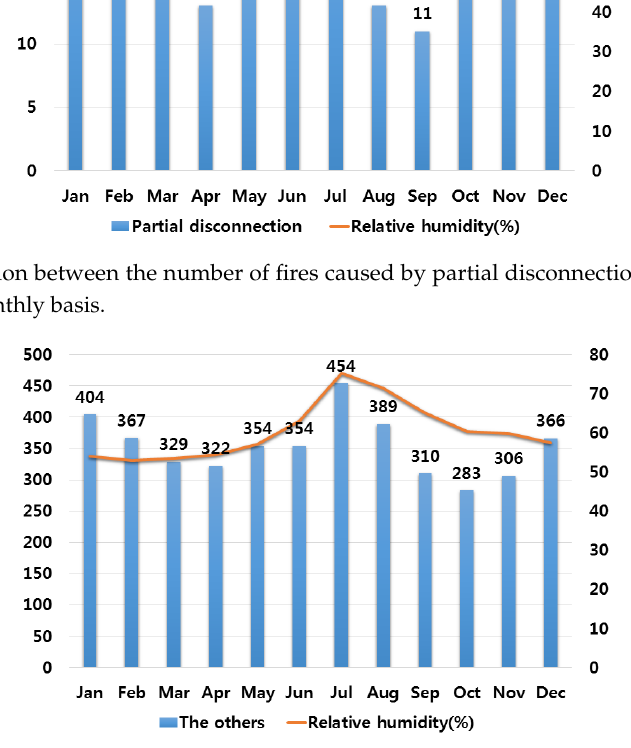
Figure 10. Correlation between the number of fires caused by other causes and the average humidity on a monthly basis.